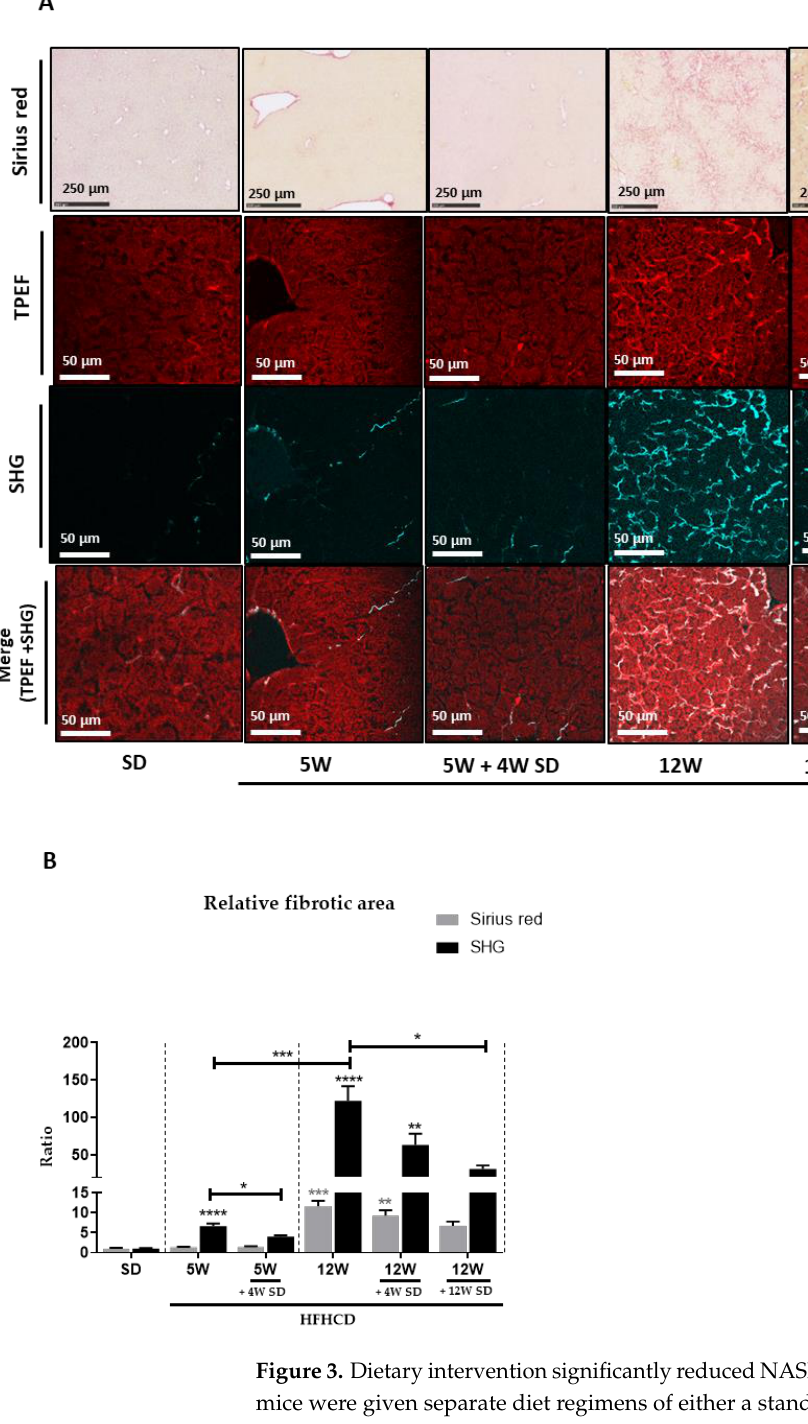
Figure 3. Dietary intervention significantly reduced NASH-induced fibrosis. Six groups of seven male mice were given separate diet regimens of either a standard diet (SD) or a high-fat, high-cholesterol diet (HFHCD) for 5 or 12 weeks (W), with some groups returning to the SD on an additional period of 4 or 12 weeks. ( A ) Liver sections either stained with Sirius red (upper panels) or multiphoton imaging by two-photon excitation fluorescence (TPEF; liver tissue auto-fluorescence; red; second line panels) and second-harmonic generation (SHG; collagen; blue; third line panels) and a merge of both (TPEF + SHG; lower panels). ( B ) Quantification of Sirius red and SHG signals; signal fold changes compared to the SD condition arbitrarily set at 1 for each approach. Statistical analysis was performed by applying non-parametric Kruskal-Wallis test (* p < 0.05, ** p < 0.01, *** p < 0.001 and **** p < 0.0001).